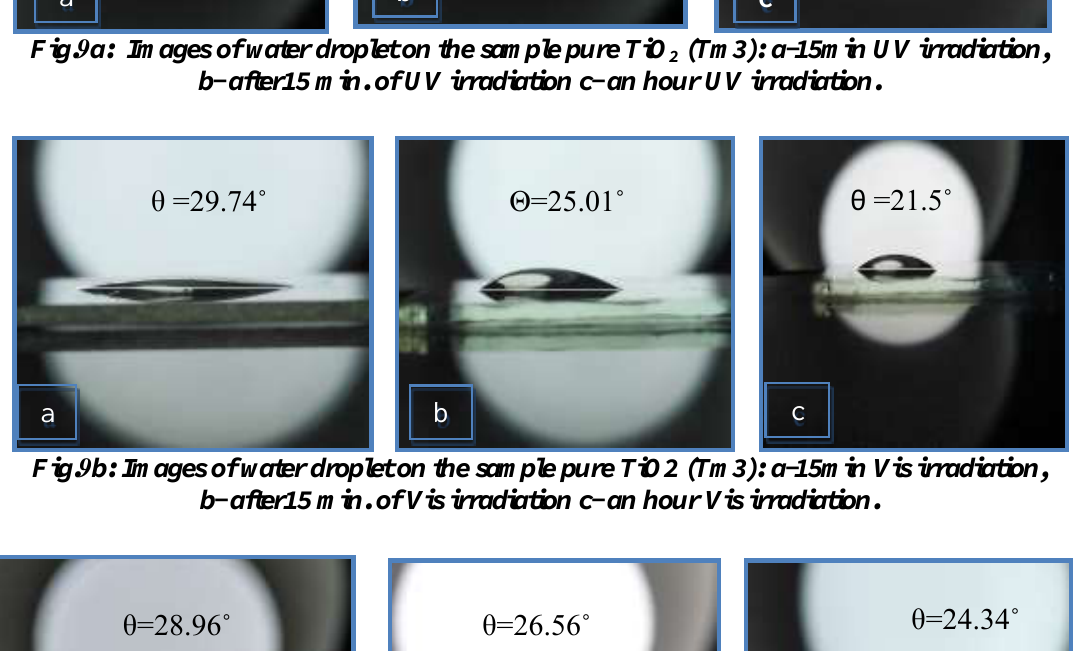
(Tm3): a-15min UV irradiation, 2